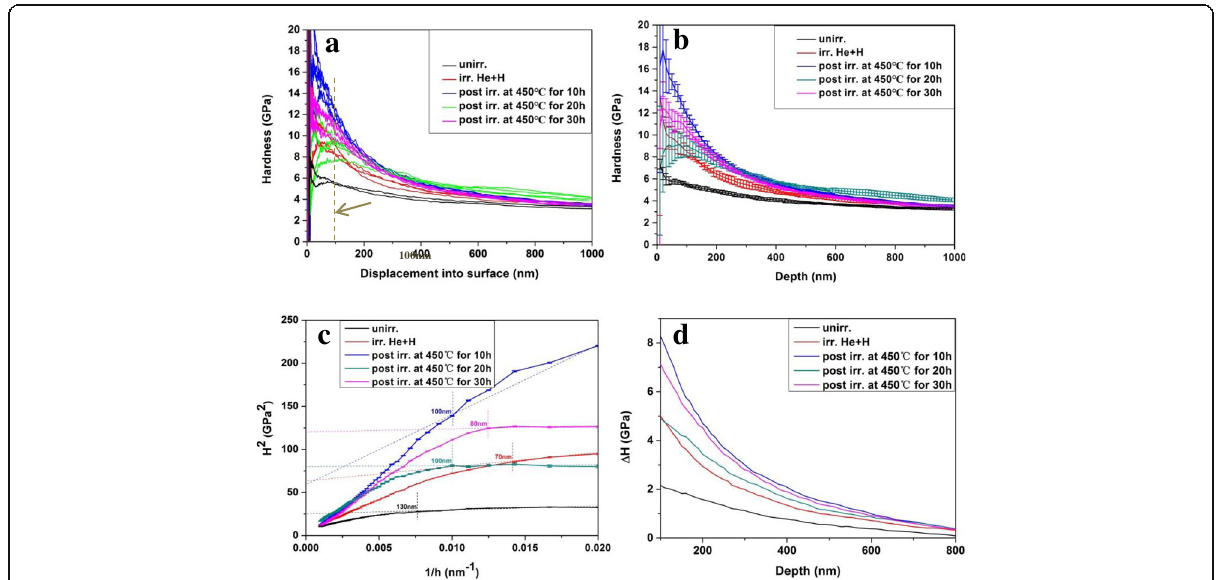
Fig. 6 Hardness in V-4Cr-4Ti alloys with different conditions. a Depth profiles of raw irradiation hardness. b Indentation depth of average nanoindentation hardness with error bar. c Plot of H 2 vs 1/h for irradiated specimens. d Experimental Δ H measurements corrected for ISE